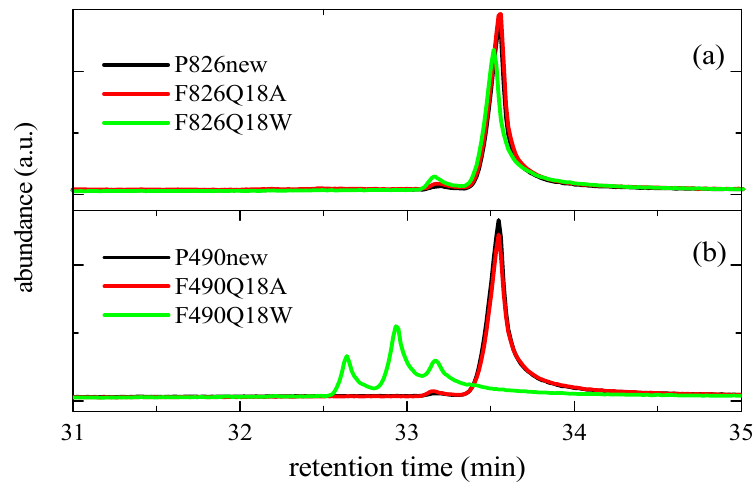
Figure 11. GC-MS chromatograms showing the degradation extent of Irganox 1330 in the indicated new pipes and aged films under two environments (warm dry air (Q18A) and hot water (Q18W)): ( a ) P826 and ( b ) P490.